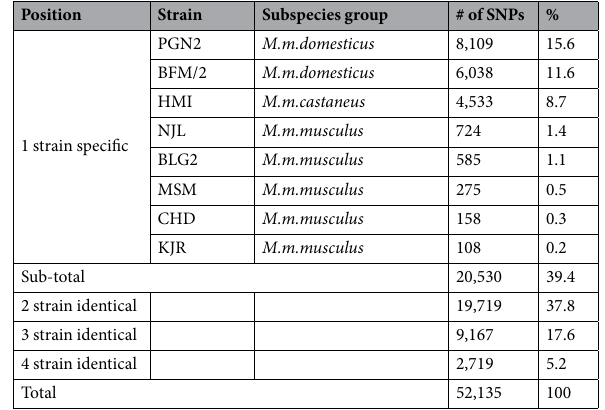
Table 1. Strain differences in single nucleotide polymorphisms (SNPs) from the GigaMUGA array. “1 strain specific” is SNPs private to a single founder strain. “%” was calculated as follows. (# of SNPs / Total) *